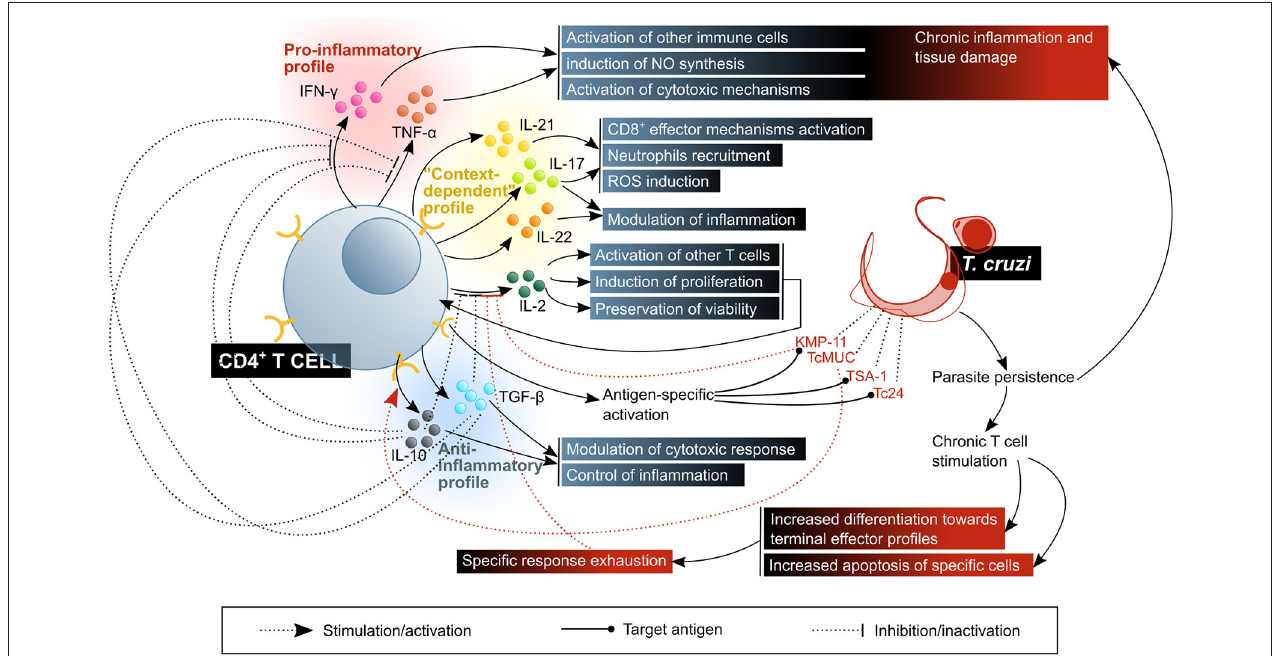
FIGURE 7 | CD4 + T lymphocytes activate, enhance or modulate mechanisms of the immune response against T. cruzi infection. The control of the disease requires a balanced response in which there is a compromise between the activation of microbicidal functions and the control of inflammatory damage. The beneficial factors for the host are highlighted in blue shaded boxes, while the factors considered harmful to the host are shown in red shaded boxes. KMP11, kinetoplastid membrane protein 11; TcMUC, T. cruzi